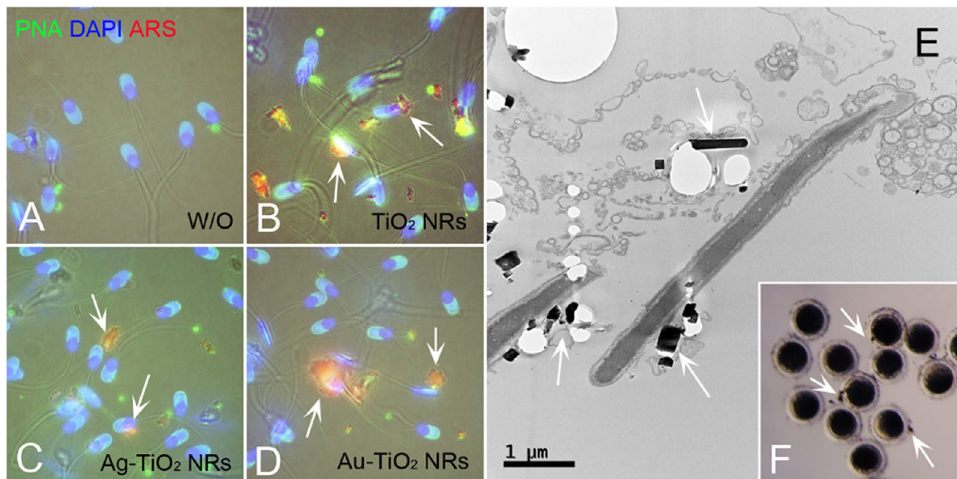
Fig. 5 Spermatozoa were incubated with alizarin red S (ARS, red), and stained with PNA (sperm acrosome, green) and DAPI (DNA, blue). A Control (without [W/O] catalyst), B TiO 2 NRs, C Ag‑loaded TiO 2 NRs, and D Au‑loaded TiO 2 NRs for 4 h. E TEM image of TiO 2 NRs attached to sperm acrosome and nuclear membrane (white arrows). F